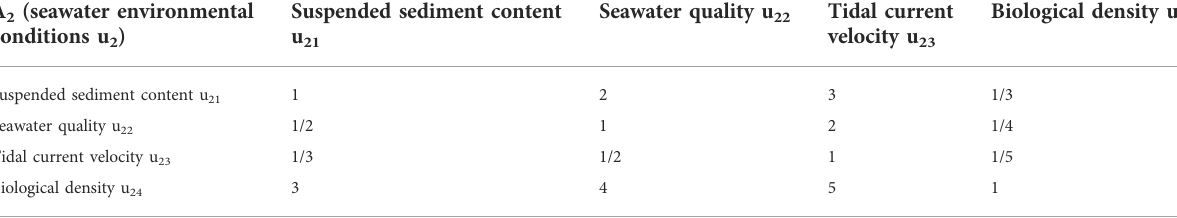
TABLE 7 Quantitative judgment of the relative importance of indexes for seawater environmental conditions.